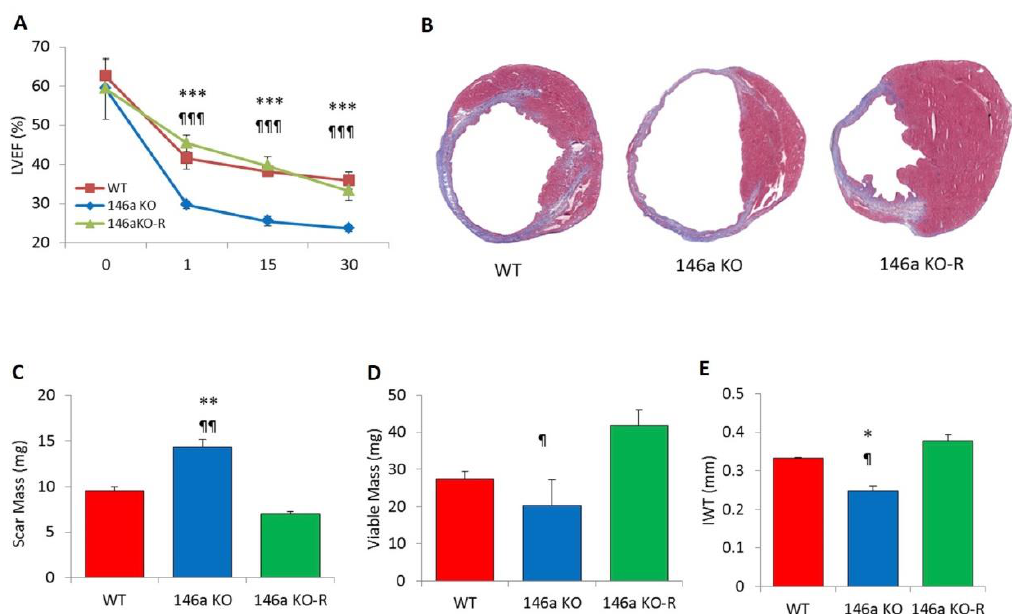
Figure 5. Involvement of microRNA (miR)-146a in the impairment of heart function after myocardial infarction (MI). ( A ) Measurement of left-ventricular ejection fraction indicates that 146a knockout (KO) animals have severely impaired cardiac function and structure following acute MI compared to wild-type (WT) or 146a KO-R mice. ( B ) Representative Masson’s trichrome-stained sections of hearts from three groups show the different tissue regeneration after MI. ( C – E ) Morphometric analysis reveals impairment of cardiosphere (CDC)-mediated benefits as evident in pooled data for scar mass, viable mass, and infarct wall thickness (IWT) in hearts of 146a KO mice. * p < 0.05, ¶ p < 0.05; ** p < 0.01, and ¶¶ p < 0.01, *** p < 0.001, and ¶¶¶ p < 0.001 using Student’s t -test (* KO versus WT; ¶ KO versus KO-R). Data are represented as means and standard errors of the mean (SEM). Modified from Reference [39].